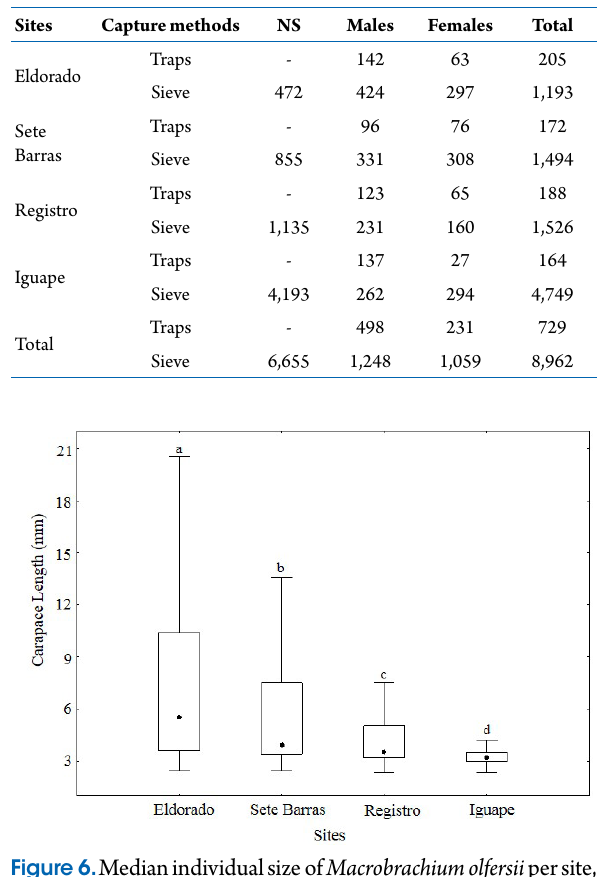
Figure 6. Median individual size of Macrobrachium olfersii per site, in Ribeira de Iguape river, São Paulo, Brazil. The boxplot shows the median: 75% and 25% quartiles; the whiskers indicate the non-outlier range; Kruskal-Wallis test: different letters indicate significant differences at p<0.05.